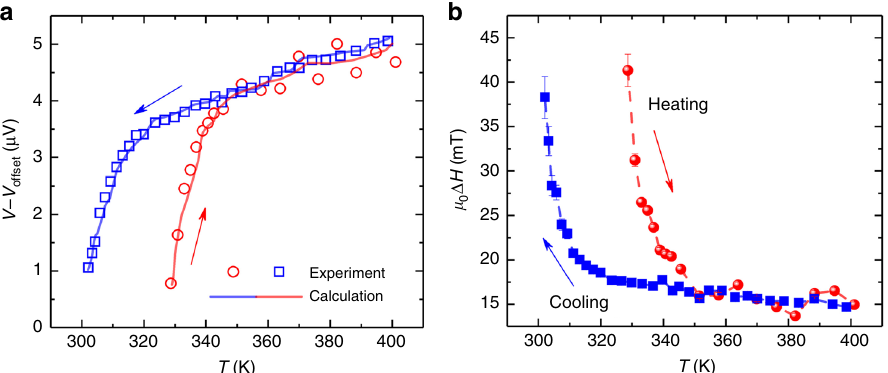
Fig. 3 Vertical spin pumping voltages during the phase transition of FeRh. a ISHE voltages measured at φ H = 0° during heating (red circles) and cooling (blue squares) for FeRh (10)/Pt at 11 GHz. The error bars are smaller than the size of the symbols. The solid lines are calculated results. b FMR linewidth as a function of T . The error bars are standard deviations obtained from the fi t of the d.c. voltage loops.